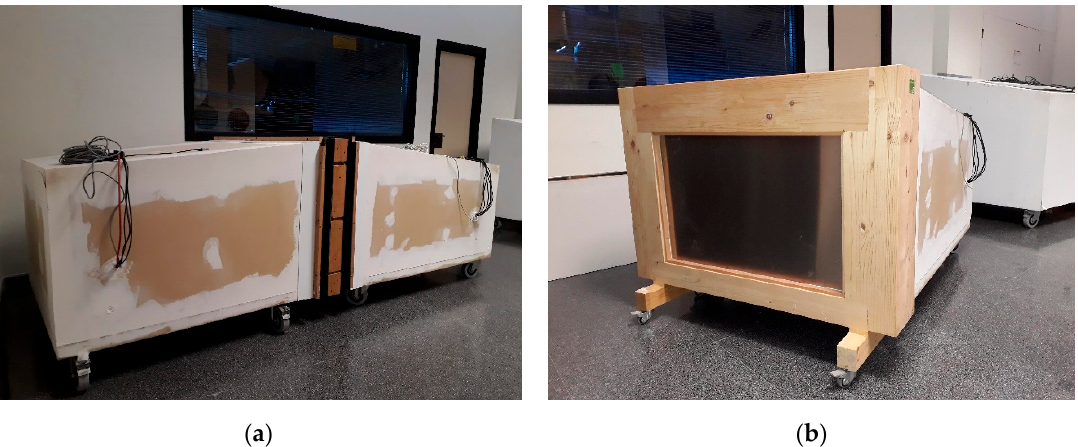
Figure 1. Completed reduced sized transmission chamber: ( a ) the two rooms with the sample holder in between; ( b ) view of the sample holder.